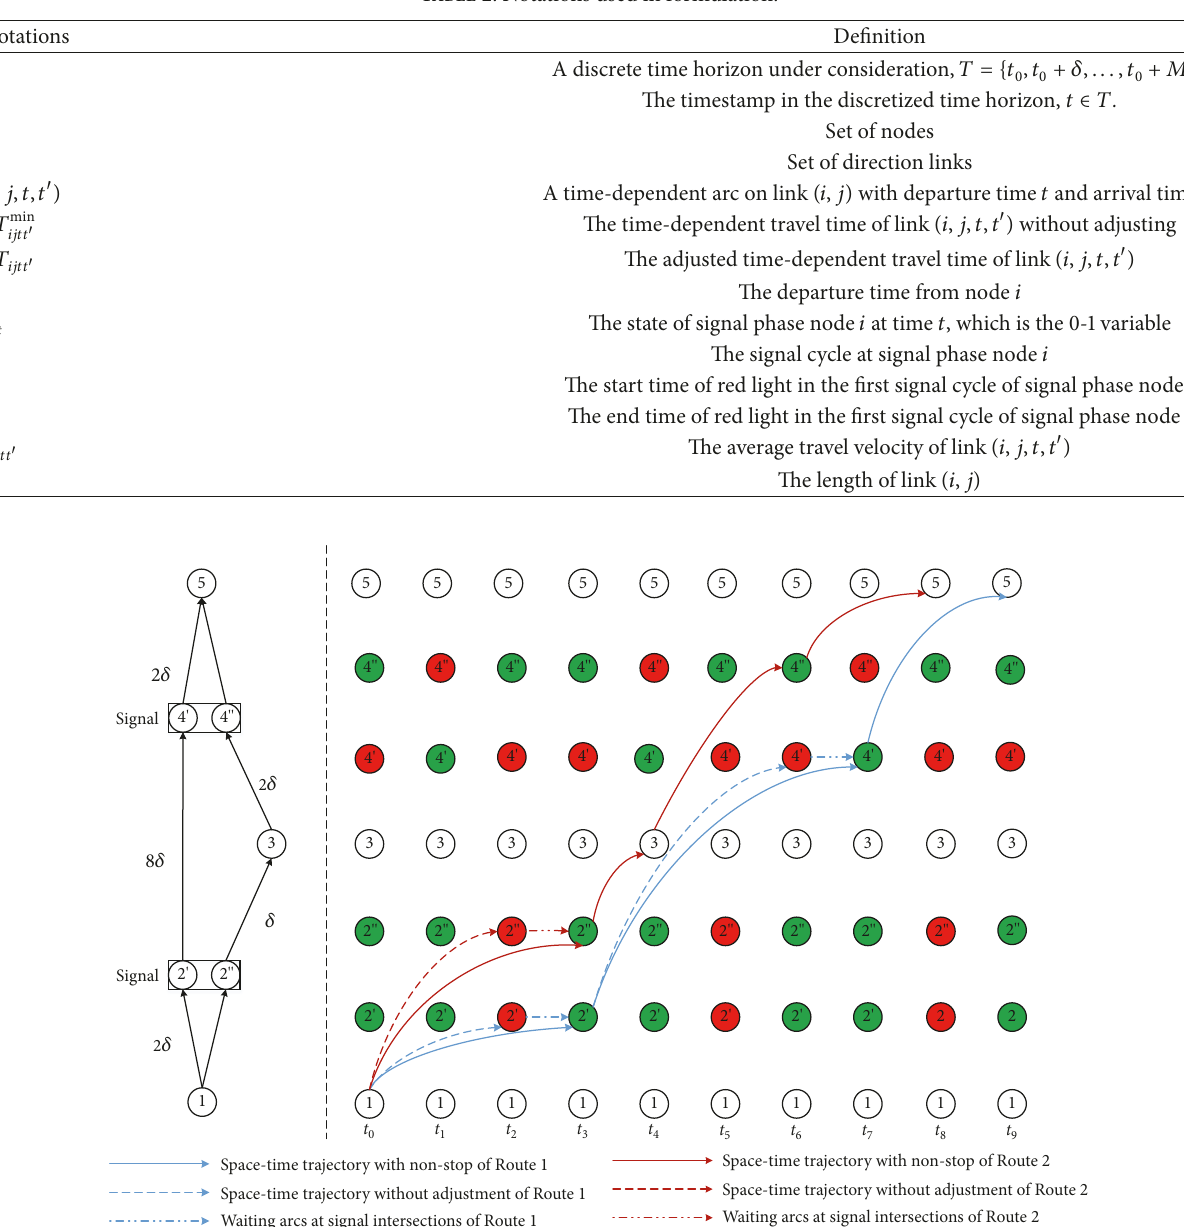
Table 2: Notations used in formulation.